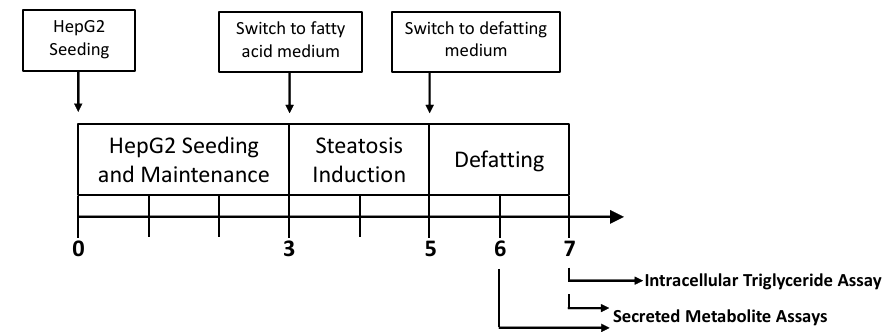
Figure 1. Experimental timeline for macrosteatotic induction and subsequent defatting. HepG2 cells were plated in basal medium for three days in six-well plates. Then, the HepG2 cells were exposed to the basal medium supplemented with free fatty acids to induce steatosis. Two days later, steatotic HepG2 cells were switched to defatting conditions, during which medium samples were taken daily, and cell extracts were harvested to measure intracellular triglyceride content.